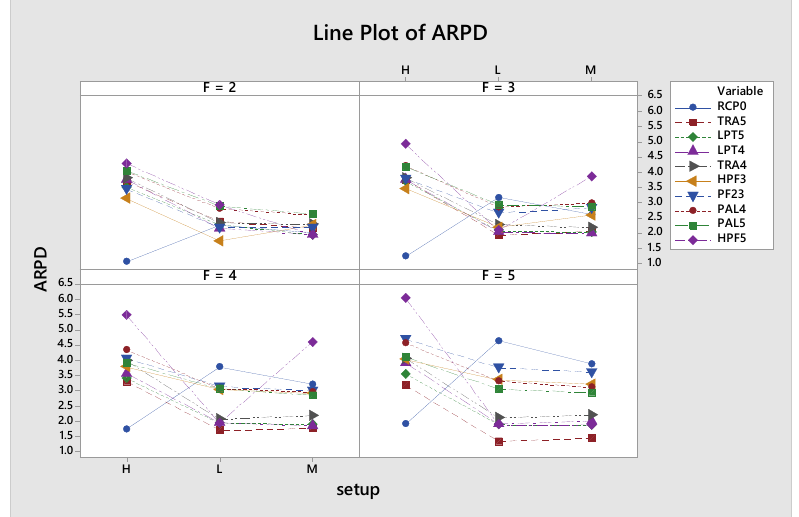
Fig. 2. ARPD per heuristic and level of setup time for each number of lines.